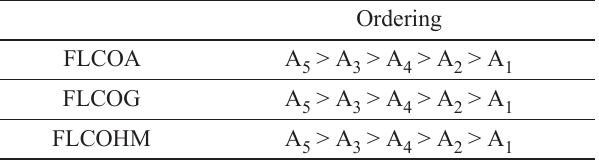
Table 3. Ordering of the alternative by utilizing the FLCOA, FLCOG and FLCOHM